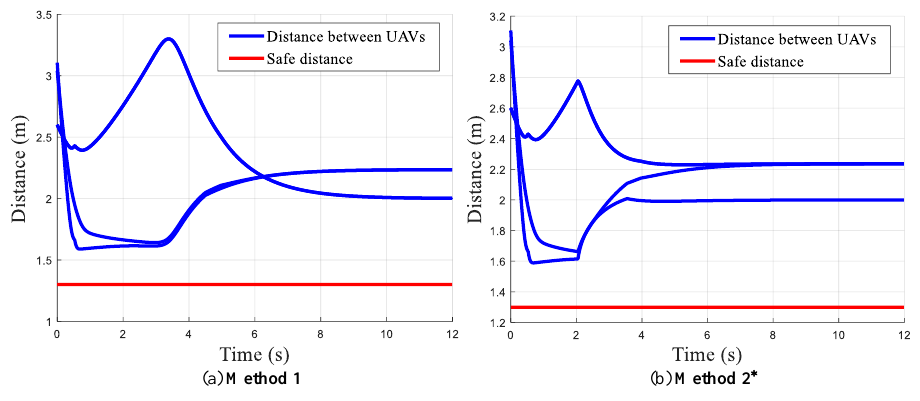
Figure 12. Distance between the UAVs. Table 4. Flight distance (m) of the three UAVs in the formation transformation process.